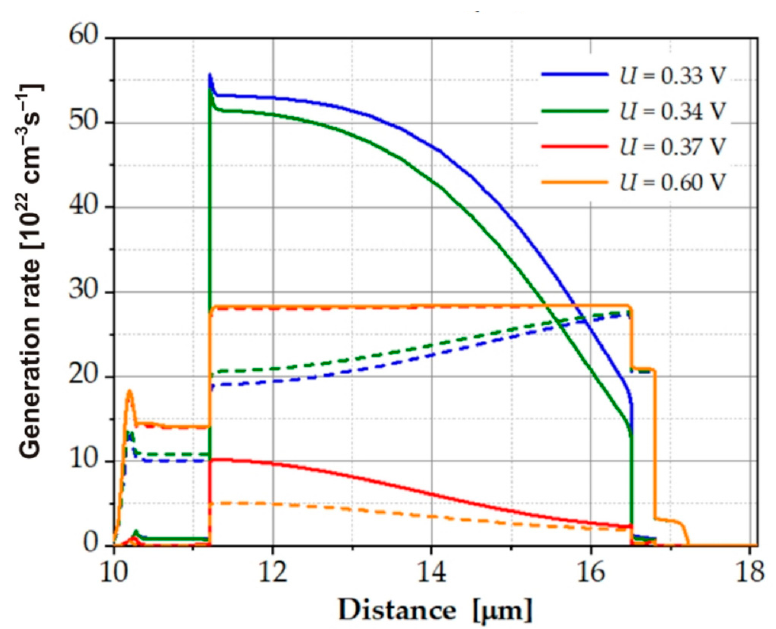
1 Figure 10. Auger (solid line) and SRH (dashed line) generation rates in reverse bias for the LWIR2 detector at T = 300 K.